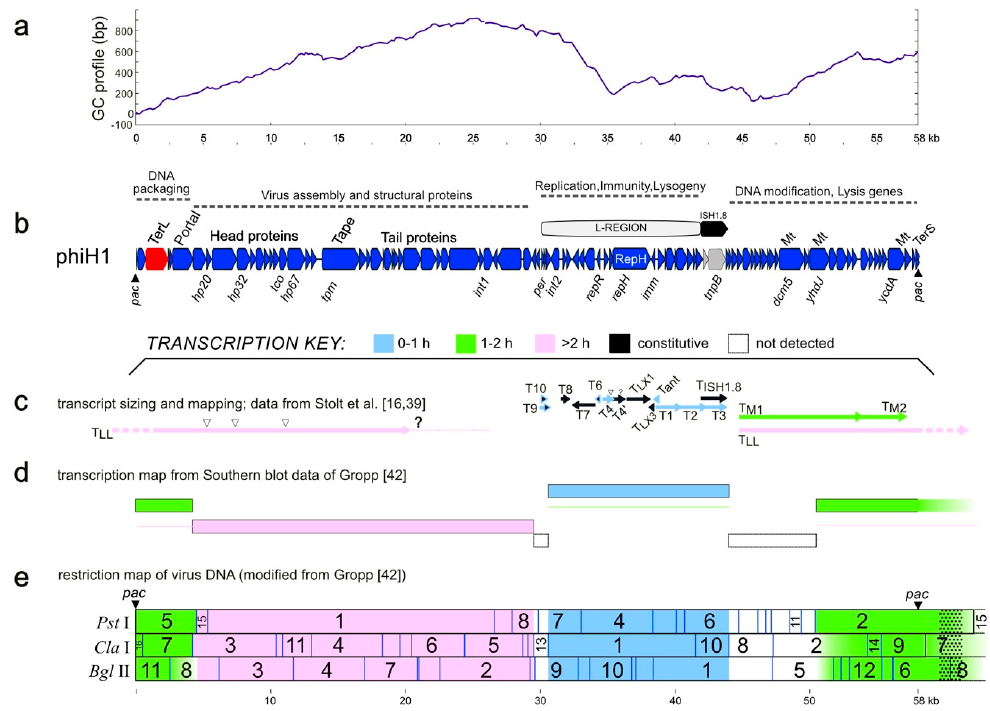
Figure 2. PhiH1 GC-profile, genetic map, and corresponding transcription program (adapted from [16,42]). ( a ) GC-profile of the phiH1 genome. ( b ) Genetic map of the phiH1 genome, showing coding sequences as red, blue or grey arrows. Dotted lines above indicate gene clusters involved in particular functions. Some CDS are labelled above the map, e.g., TerL, terminase large subunit; Portal, portal protein; Tape, tape-measure protein; RepH, replicase (label within CDS arrow); Mt,